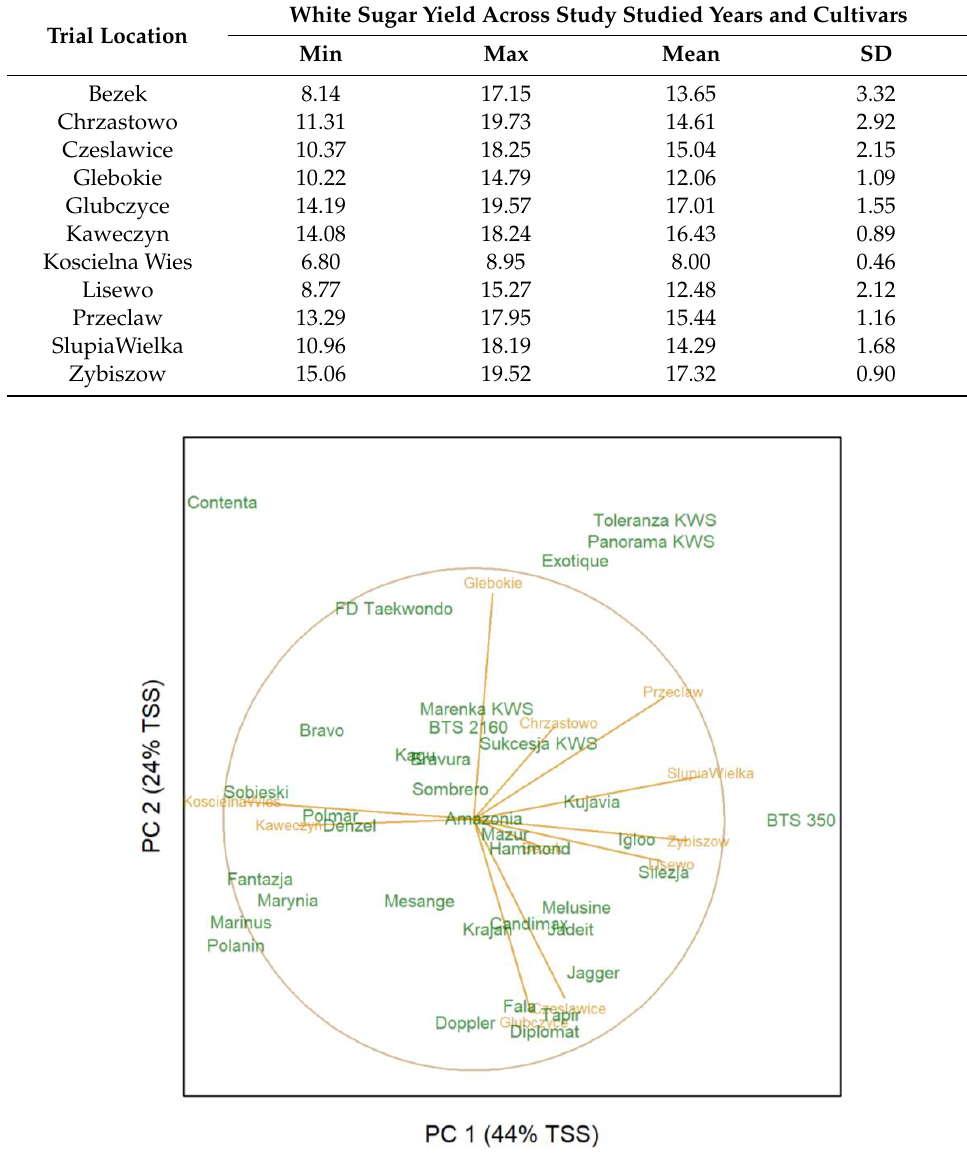
Table 4. Basic statistics of white sugar yield (t ha − 1 ) for studied trial locations across studied years and cultivars.